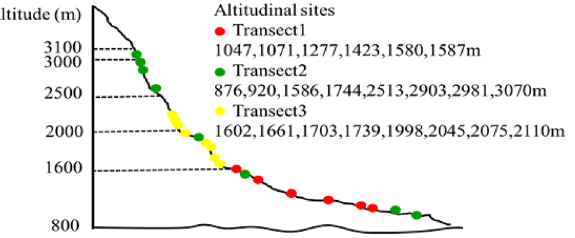
Figure 6. The locations of selected Mt. Tianshan grassland study sites along an elevation gradient. It was created using Adobe Illustrator CS6 (Adobe Software,